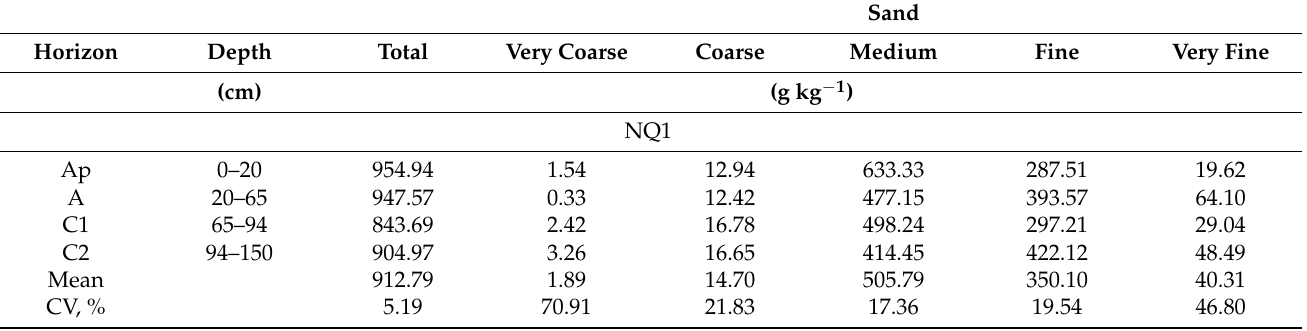
Table 2. Sand size distribution of the Quartzipsamments profiles of the Southwest of Rio Grande